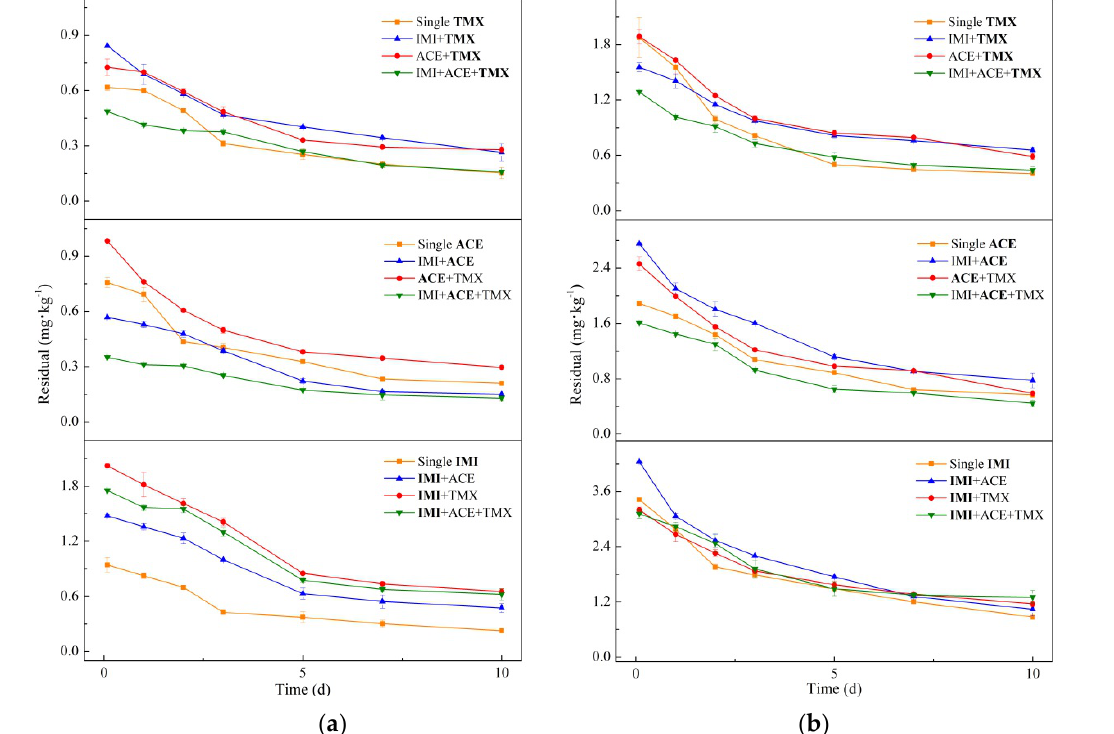
Figure 1. Different recommended doses of three neonicotinoid residues in Brassica chinensis L.: ( a ) dose A; ( b ) dose B. The points and error bars represent the mean and standard deviation of replicates, respectively ( n = 3).